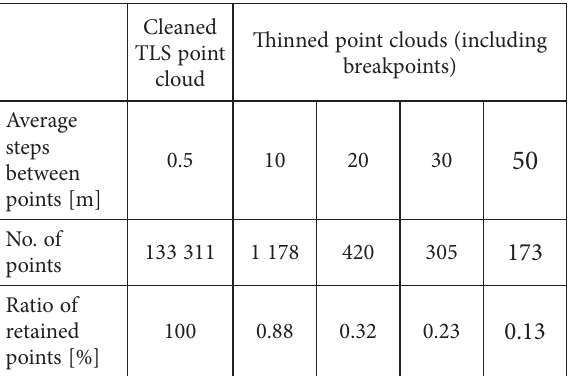
Table 1. The amount of data-points used in comparisons Cleaned